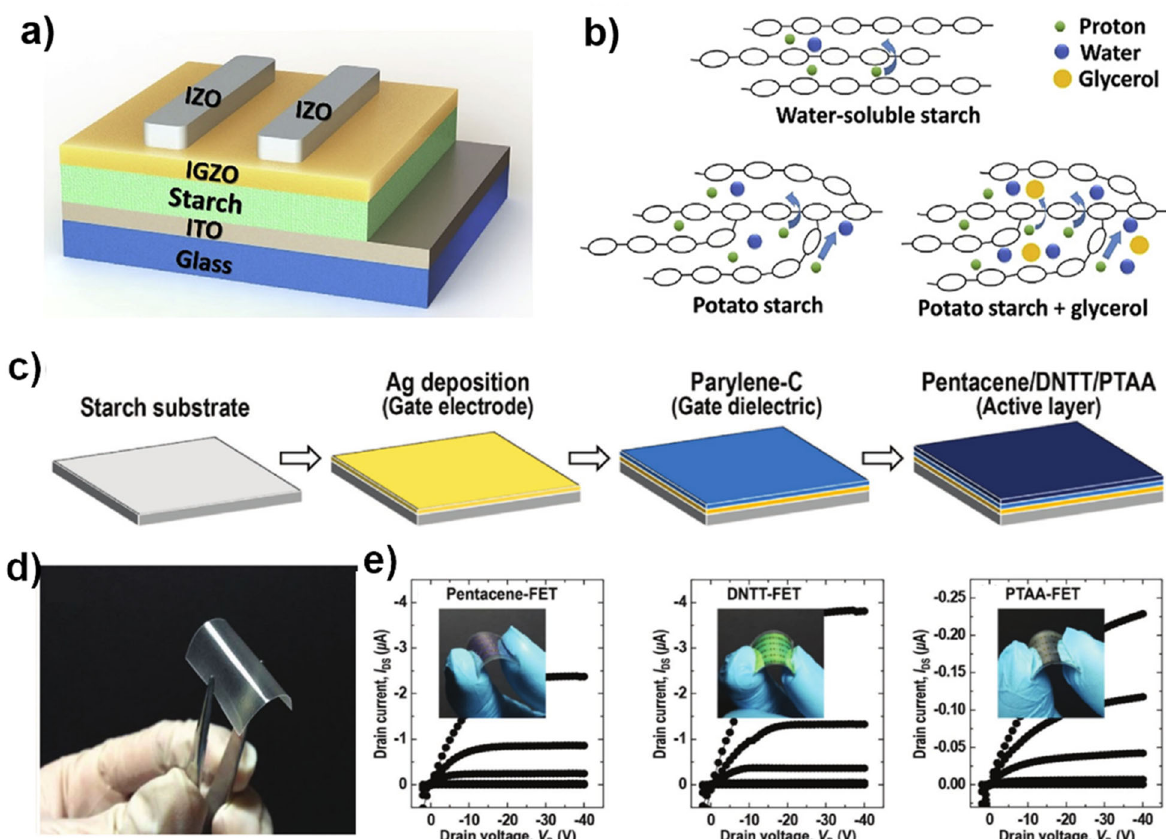
Fig. 6 Organic transistor based on starch fi lms. a Device structure of the thin fi lm transistors with starch as the ion-based gate dielectric. b Schematic illustration of the proposed ion (proton) transportation in the starch-based gat dielectrics. Reproduced with permission 128 . Copyright 2017, Elsevier. c Schematic diagrams of fabrication process of the OFET based on starch-PVA fi lm. d Photograph of the fl exible starch-PVA fi lm. e Output characteristics of various fl exible devices fabricated on the starch-PVA fi lm. The inset images in ( e ) show the fabricated devices and their fl exible features. Reproduced with permission 92 . Copyright 2018,